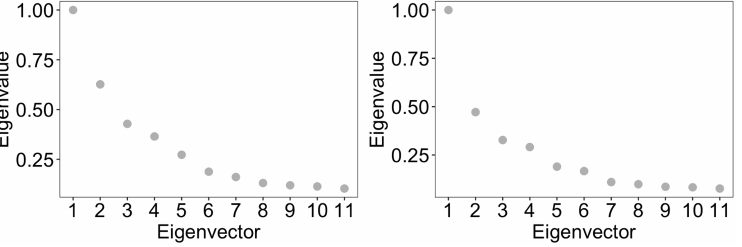
Figure A6. Eigenvalues of the Laplacian graph based on each affinity matrix for healthy and disease (ECC) groups in ZOE 2.0 Kraken2/Bracken microbiome data, used to determine an appropriate number of